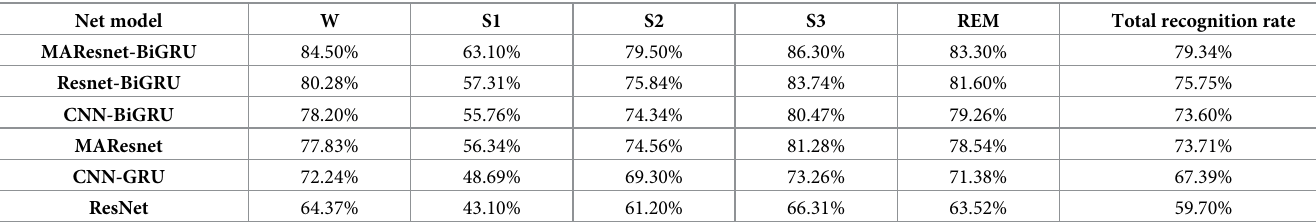
Table 4. Recall rate of each sleep stage classification under different algorithms under label smoothing on UCD dataset.